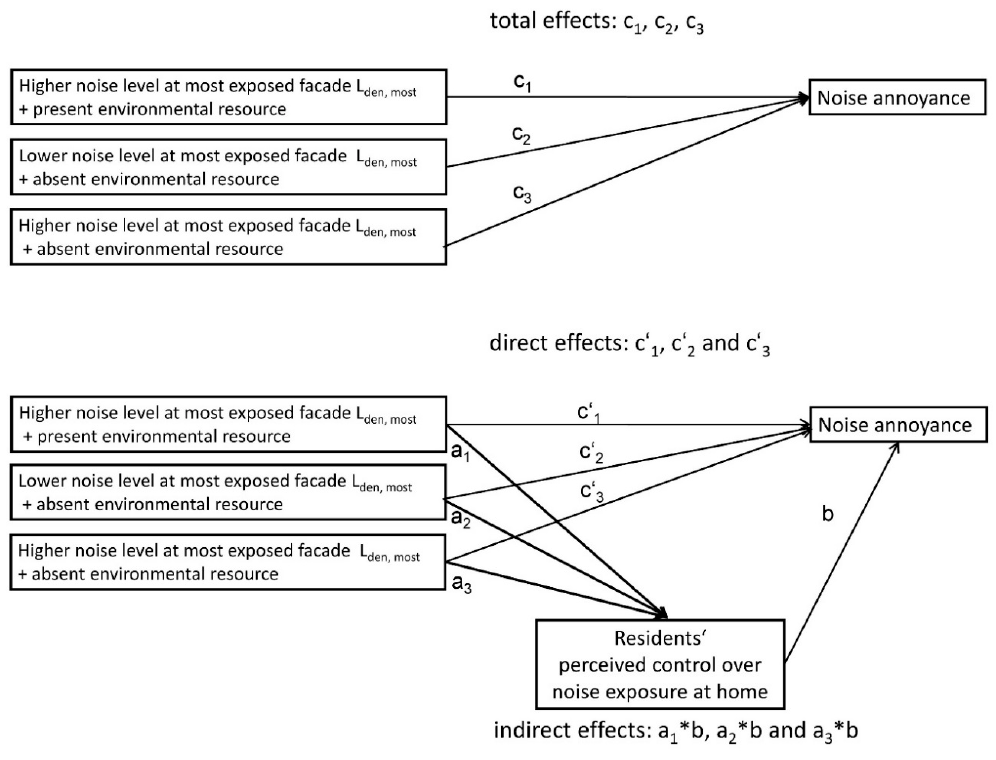
Figure 2. Associations under study for the second objective. Shown are potential total, direct, and indirect effects we aimed to quantify.